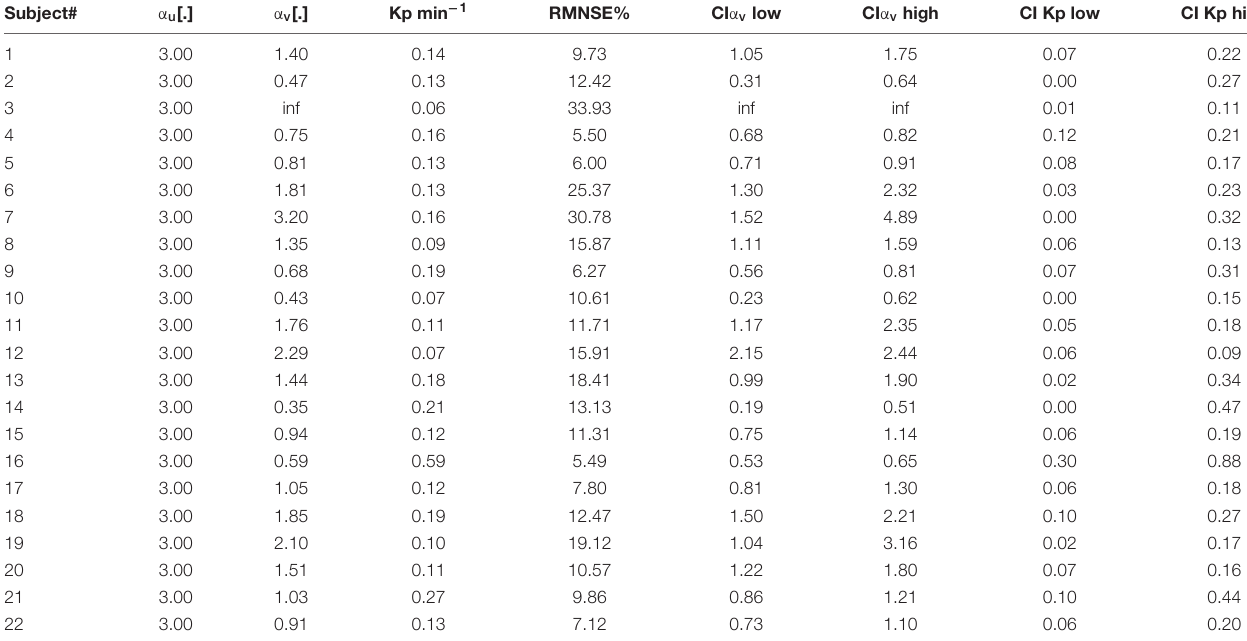
TABLE 3 | Uncertainty Quantification of the parameters for two parameter model after fixing α u to